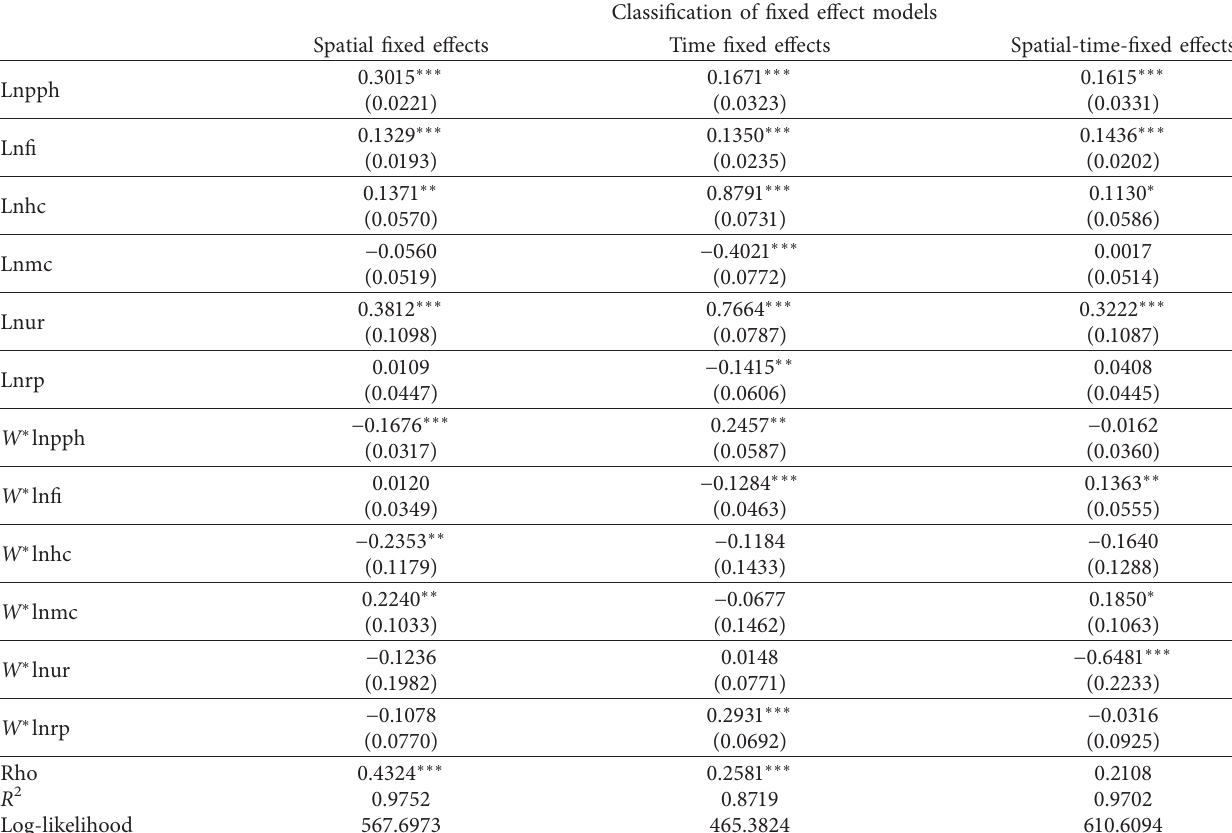
Table 6: Estimation result of SDM at national level.